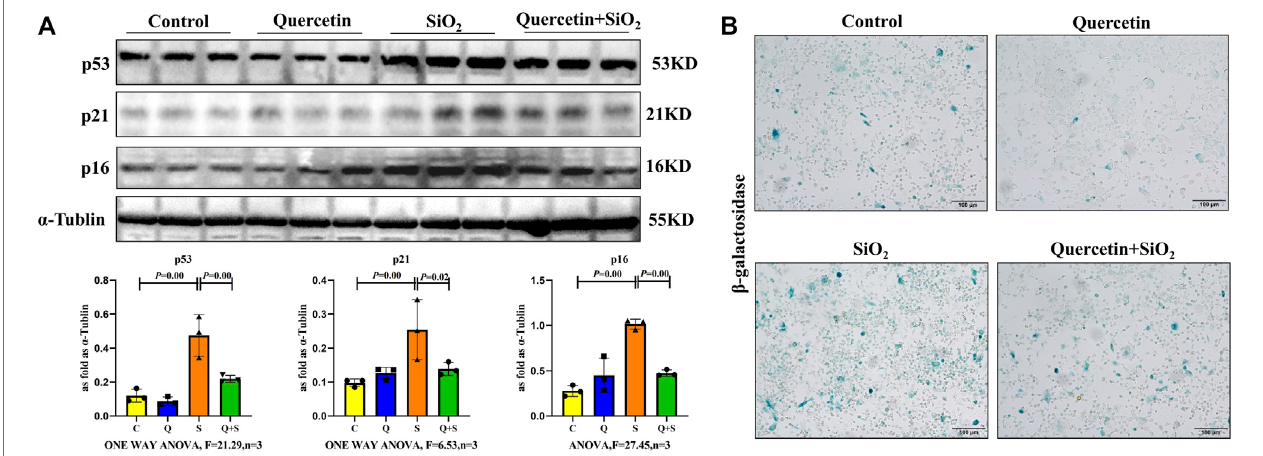
FIGURE5| QuercetininhibitsSiO 2 -inducedmacrophagesenescence. (A) p16,p21andp53expressionsbywesternblot. (B) SA- β -galstaininginRAW264.7cells. Data are presented as the mean ± SD. n = 3 per group.